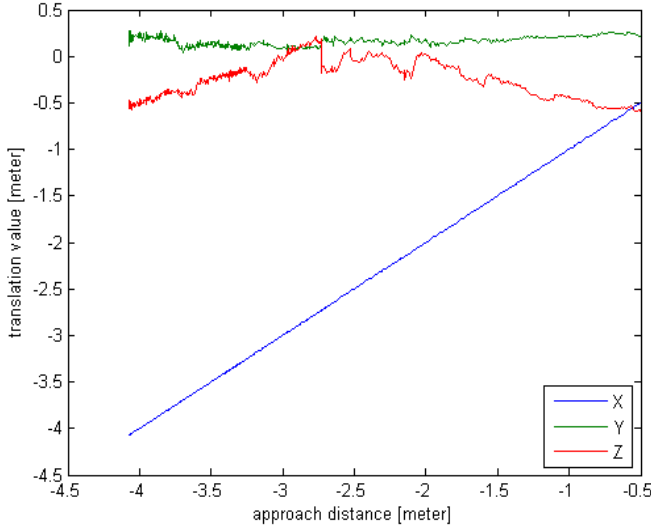
Figure 14. The rotation angle value curve for field experiment.